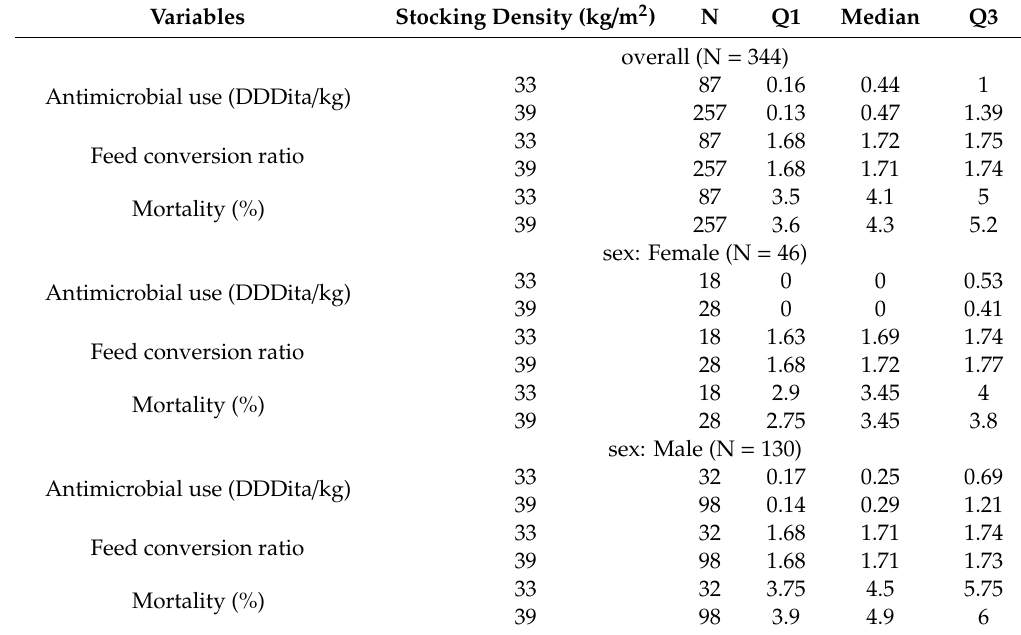
Table 1. Descriptive statistics of antimicrobial use, feed conversion rate, and mortality in 344 broiler farms in